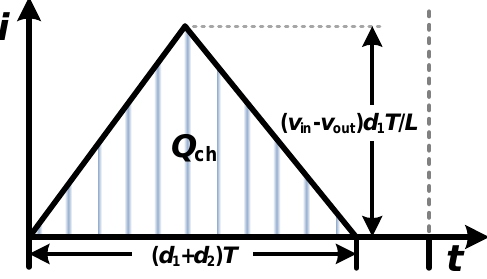
Figure 3. Output charge of buck converter under discontinuous conduction mode (DCM).